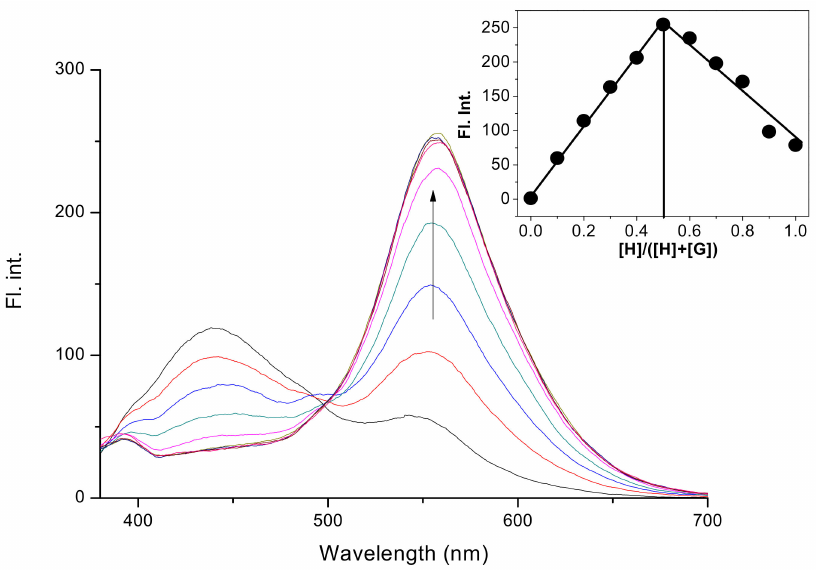
Figure 4. Fluorescence titration of 2b (10 µ M) recorded with various amounts of Cd 2+ (0 to 1.6 equiv.). Inset: Job plot analysis of the interaction between 2b and Cd 2+